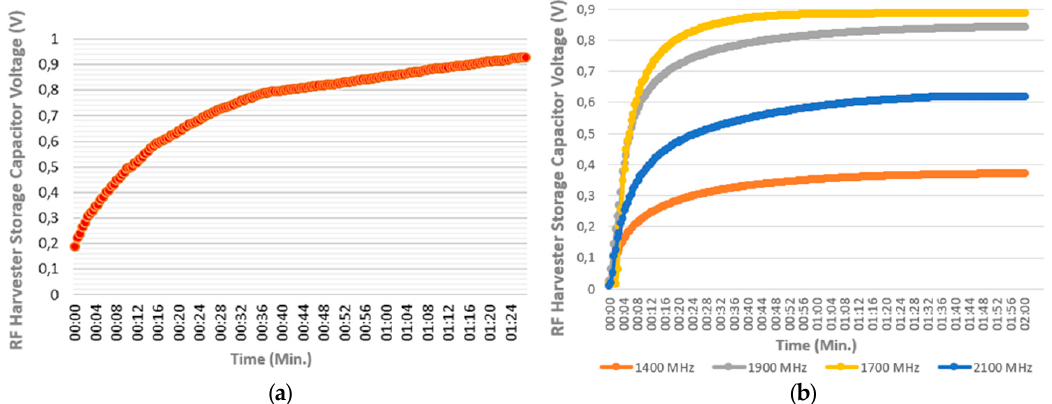
Figure 5. ( a ) The broadband Discone rectenna experiment setup nearby a base station in the urban environment, at Heraklion, Cr